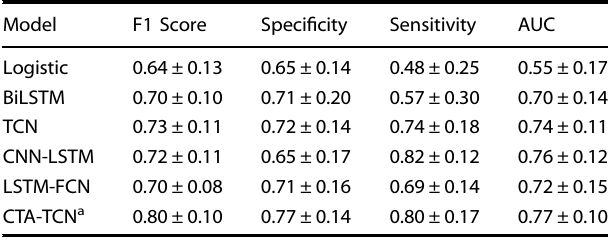
Fig. 1 Signi fi cant features pre- to post-opioid administration. a HR Features, b IBI Features, c Skin Temperature Features, and d EDA and ACC Features. Dark blue Pre-Opioid Mean, Light Blue Post-Opioid Mean. Max Maximum, SD Standard deviation, IBI Interbeat interval, SDNN SD of NN intervals, VLF Logarithmic of absolute power of very low frequency band, LF Logarithmic of absolute power of low frequency band, LF(nu) Normalized absolute power of LF band, IQR Interquartile range, EDA Electrodermal Activity, ACC Accelerometry, Min Minimum, Freq Frequency. Table 4. Performance metrics for all machine learning